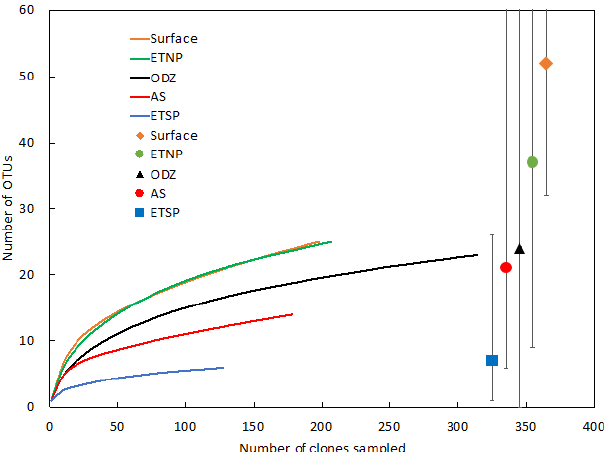
Figure 2. Rarefaction curve displaying observed OTU richness vs. the number of clones sequenced for Cluster I nifH sequences (cDNA and DNA). OTUs were defined and designated as in Fig. 1. Chao es- timators (individual symbols) are shown for each of the same sub- sets represented in the rarefaction